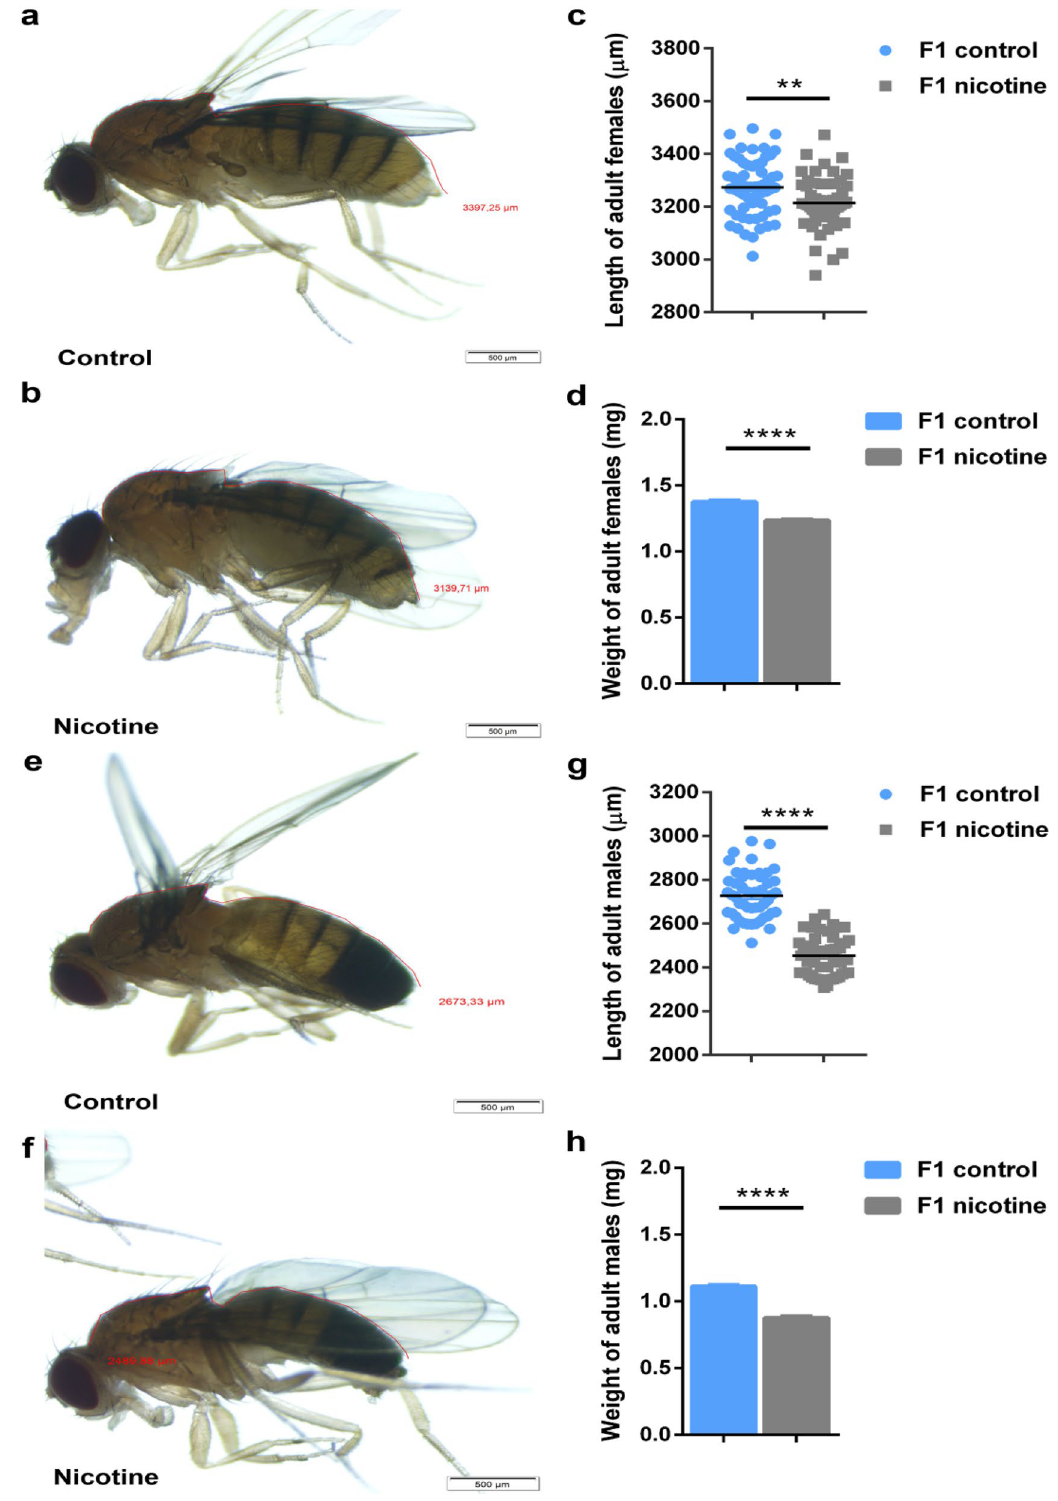
Figure 6. The length and weight of F1 adult flies. ( a , b ) Stereomicroscope image of the F1 female adult flies from the maternal e-nicotine-treated ( b ) and control ( a ) groups. ( c , d ) quantification of the length (μm) ( c ) and weight (mg) ( d ) of F1 adult female flies. ( e , f ) Stereomicroscope images of F1 male adult flies from the maternal e-nicotine-treated ( f ) and control ( e ) groups analysed using the image software cellSens. ( g , h ) quantification of the length (μm) and weight (mg) of the adult male flies. ( a , b , e , f ) red line represents the measurement of the adult fly body length. Values are mean ± SEM, unpaired t-test, **p = 0.001, ****p < 0.0001, n = 3 independent experiments. Bar represents 500